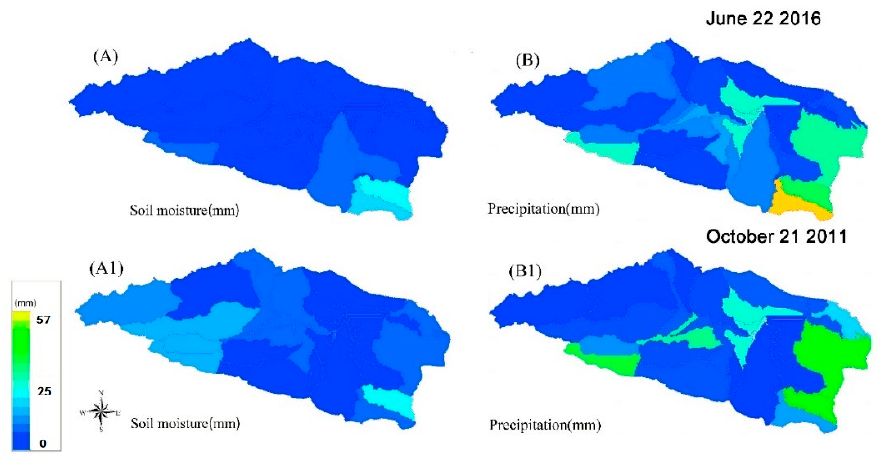
Figure 13. Correlation analysis of the soil moisture and precipitation in the JBR.